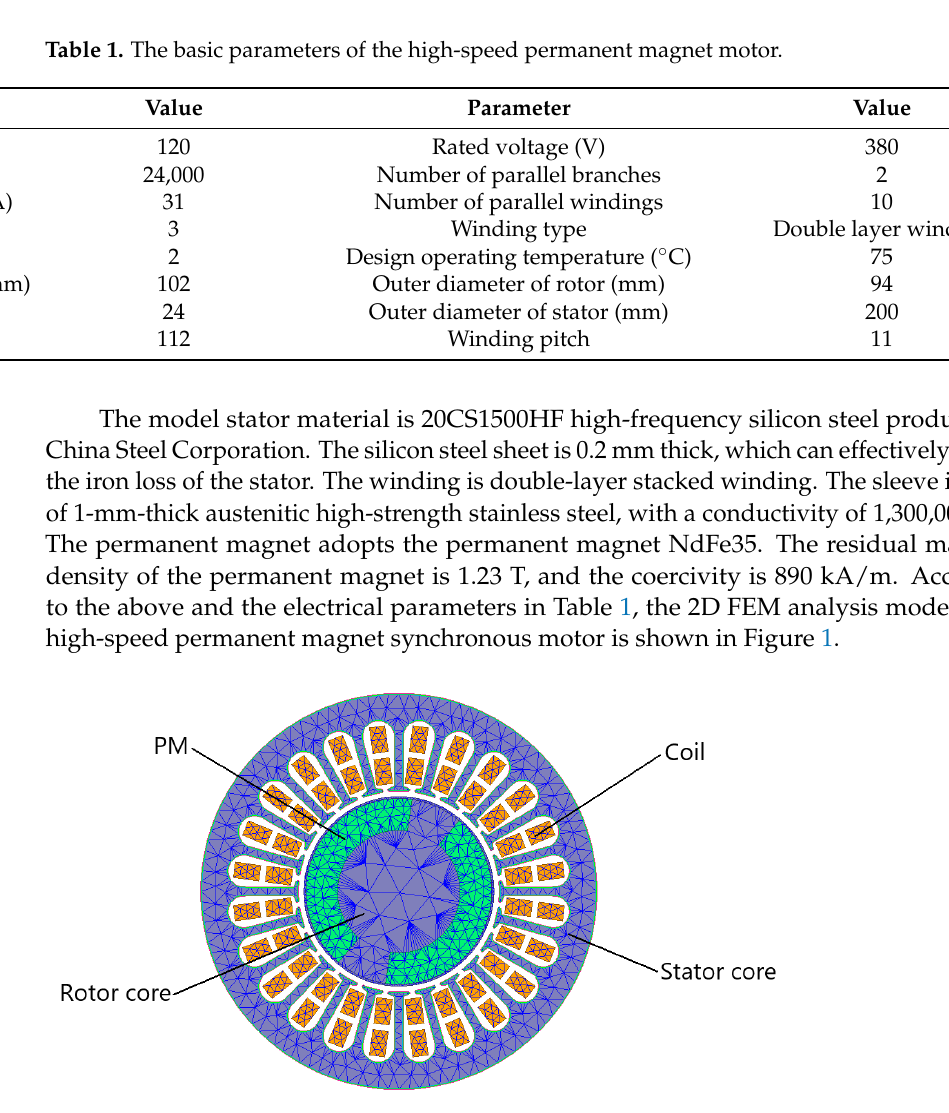
Table 1. The basic parameters of the high-speed permanent magnet motor.